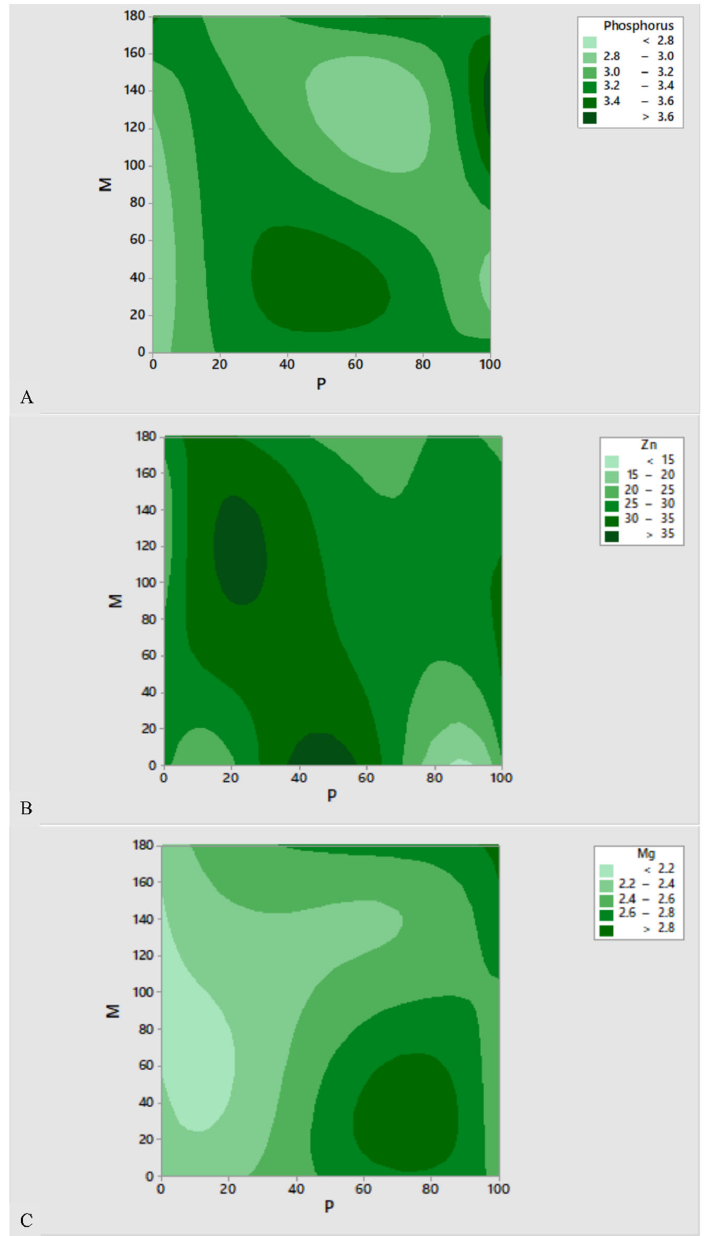
Figure 2. Response surfaces for foliar P content ( A ), foliar Zn content ( B ), and grain Mg content ( C ) as a function of P 2 O 5 supplied to the soil and the mycorrhizal inoculant in corn seeds in the 2020 experiment. Phosphate fertilization affected the foliar K content in 2019 ( p < 0.05), with a quadratic regression equation fitting (R 2 = 83.57%) and a peak at 76.57% P 2 O 5 (Figure 3a). In the same